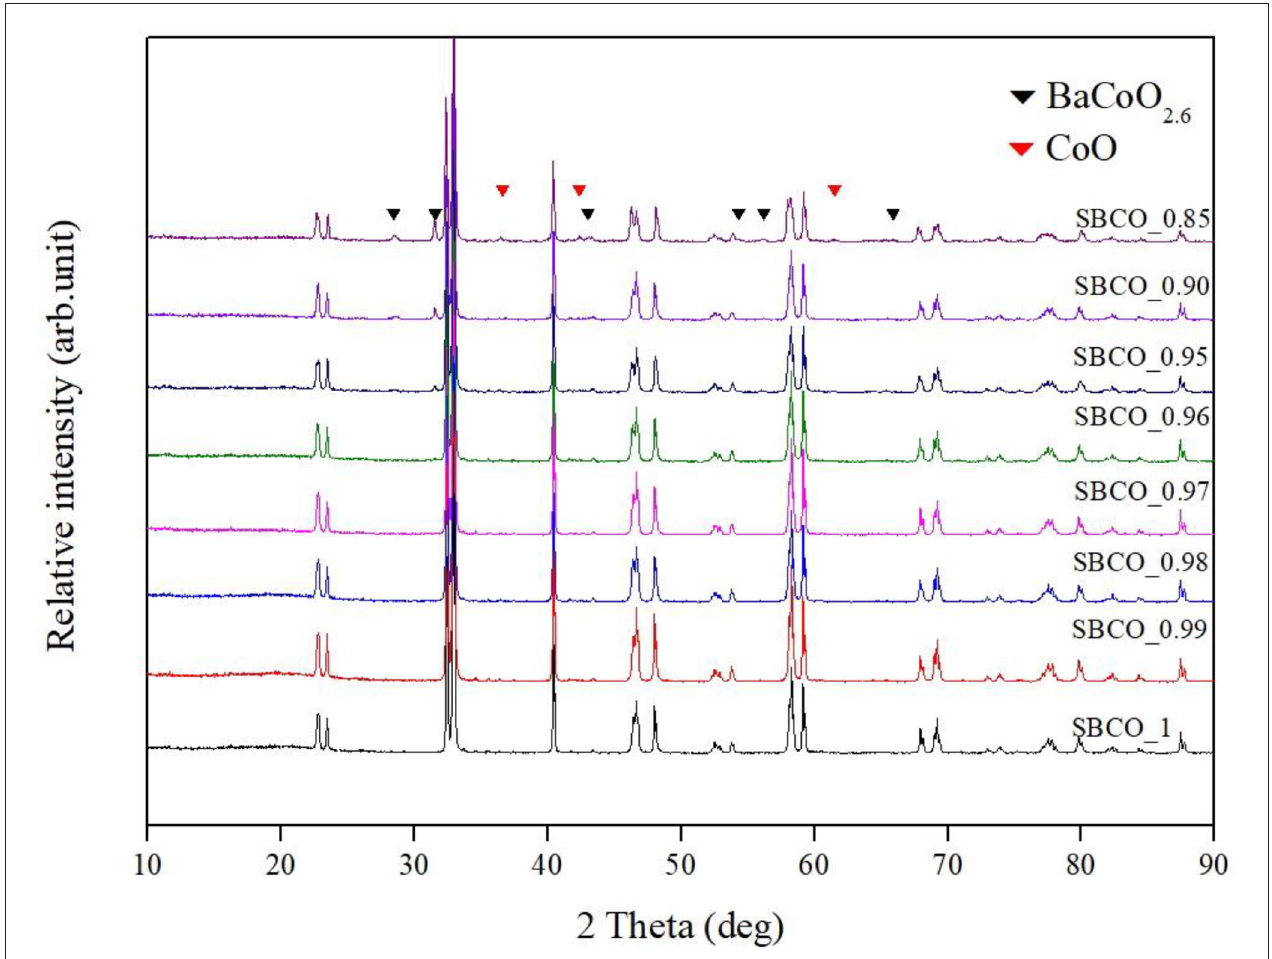
FIGURE 1 | X-ray diffraction (XRD) patterns of Sm 1 − x BaCo 2 O 5 + d ( x = 0, 0.01, 0.02, 0.03, 0.04, 0.05, 0.10, and 0.15) oxide systems calcined at 1,100 ◦ C for